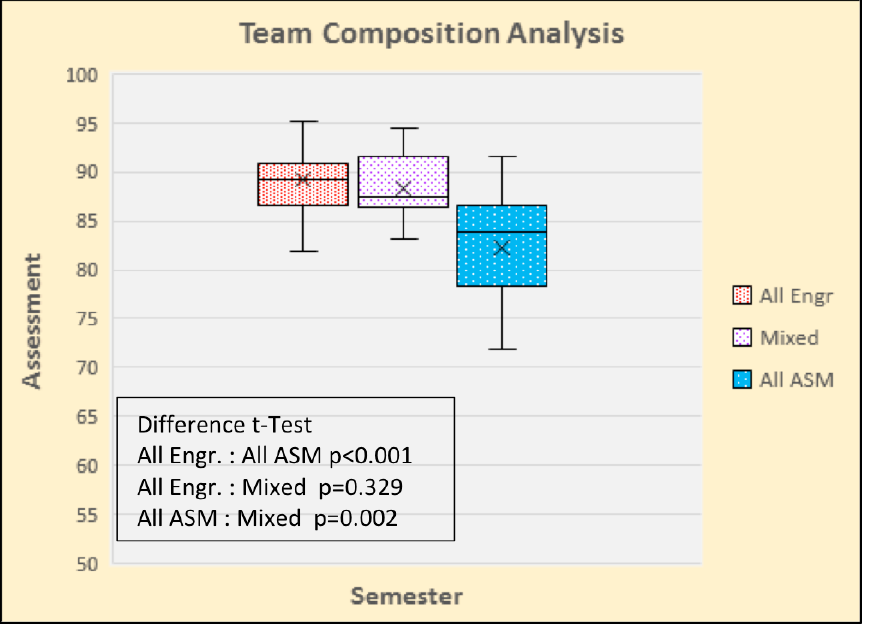
Fig. 3. Comparison of Lab Course Final Indices by Team